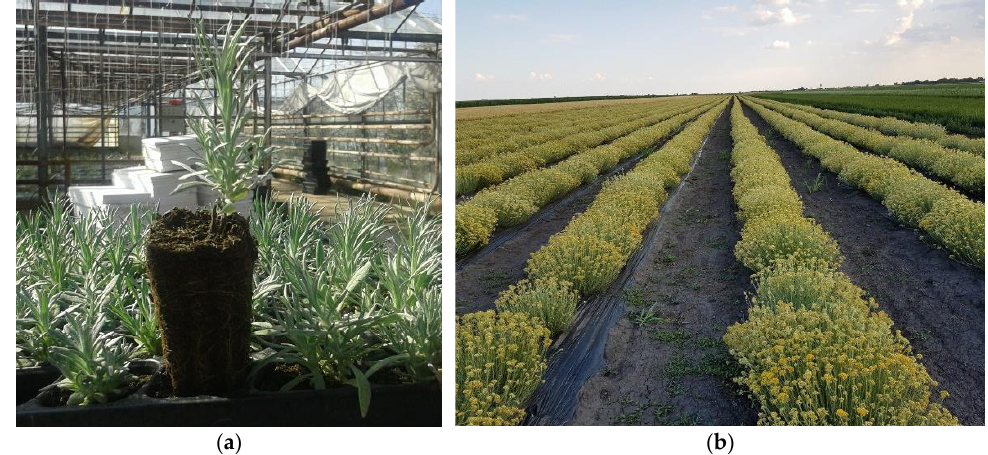
Figure 1. Immortelle seedlings production in a greenhouse, ready for transplantation ( a ); immortelle production field ( b ).